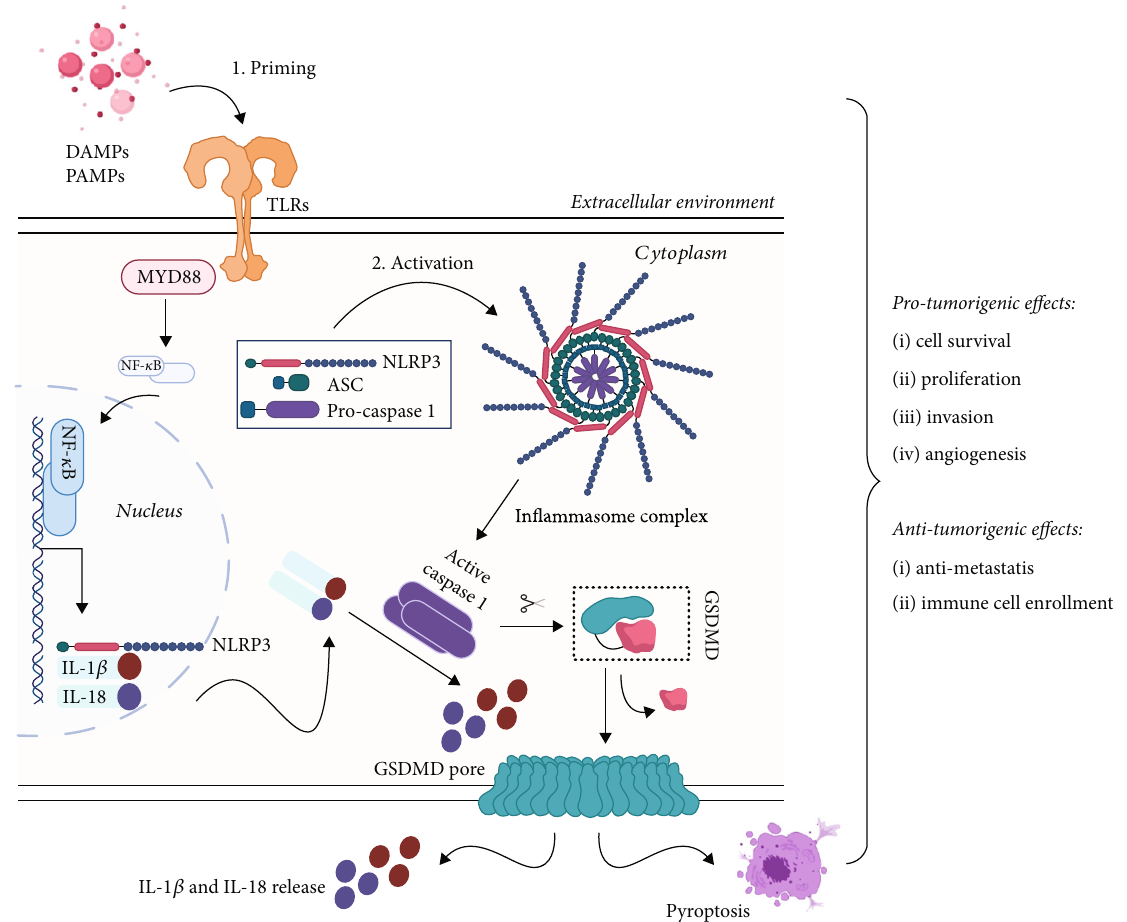
Figure 2: The canonical pathway and activation mechanism of in fl ammasomes and outcomes in cancer. PAMP and DAMP signals are recognized by PRRs/TLRs, which then lead to activation of caspases. Active caspase-1 will promote the IL- β and IL-18 release or pyroptosis initiation, through GSDMD cleavage and pore formation (image created in